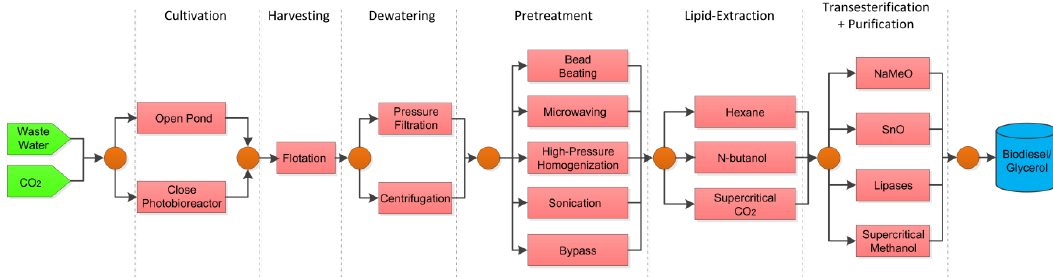
Figure 8. Integrated Algae- and Wheat Straw- Biorefinery that Supplies the CO 2 and Nutrients in the Wastewater, adapted from [48].